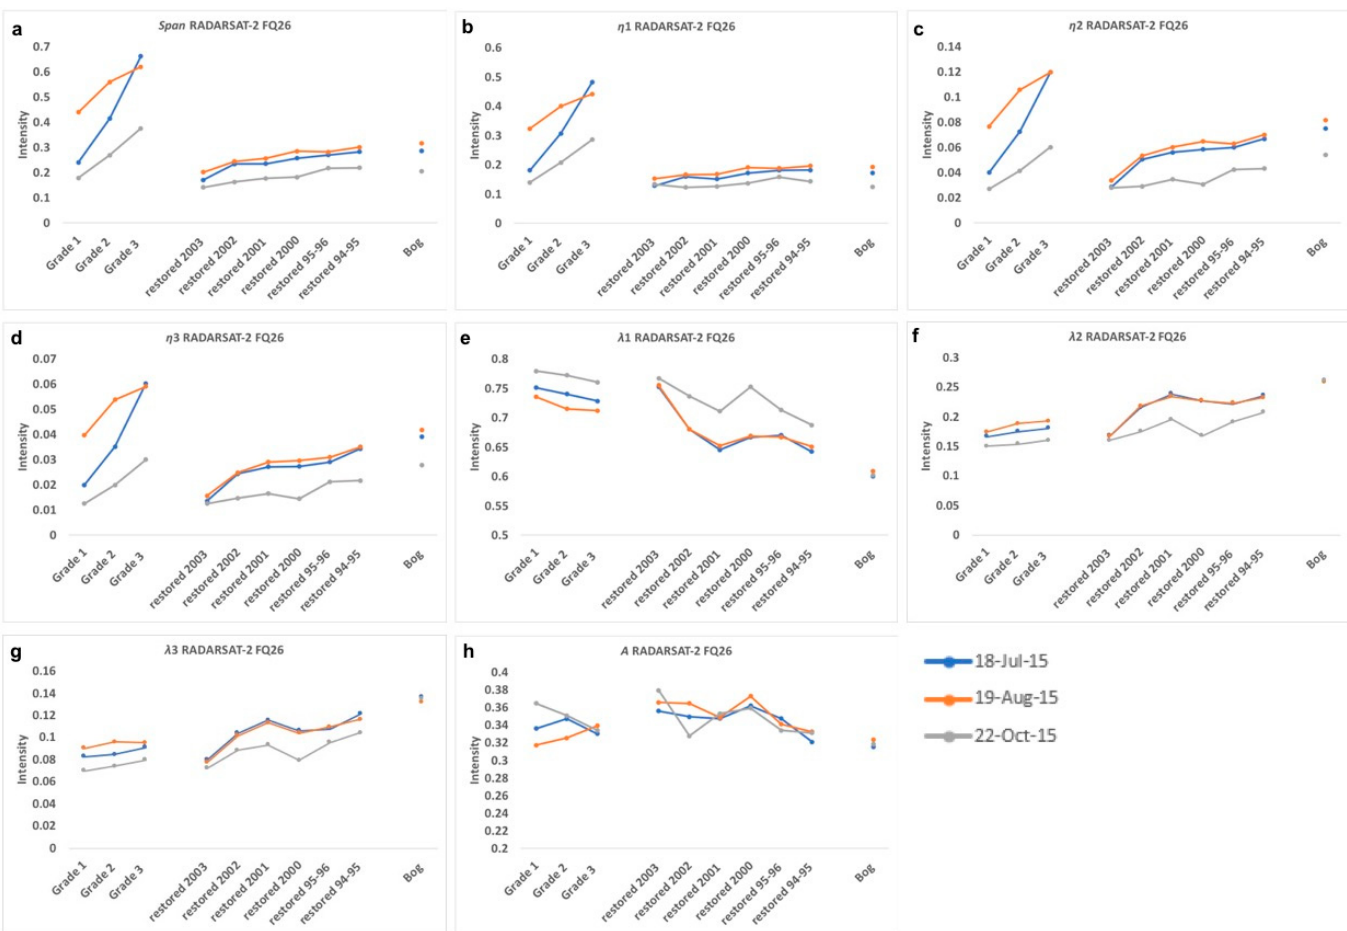
Figure 5. Spectral signatures for natural shrub bog, restored peat, and actively harvested peat using the RADARSAT-2 FQ26 images. ( a ) Total power (span), ( b ) dominant eigenvalue, ( c ) secondary eigenvalue, ( d ) tertiary eigenvalue, ( e ) normalized dominant eigenvalue, ( f ) normalized secondary eigenvalue, ( g ) normalized tertiary eigenvalue, and ( h ) anisotropy.